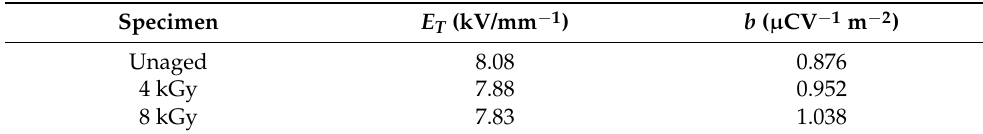
Table 1. Parameter values of unaged and gamma irradiated samples [29].